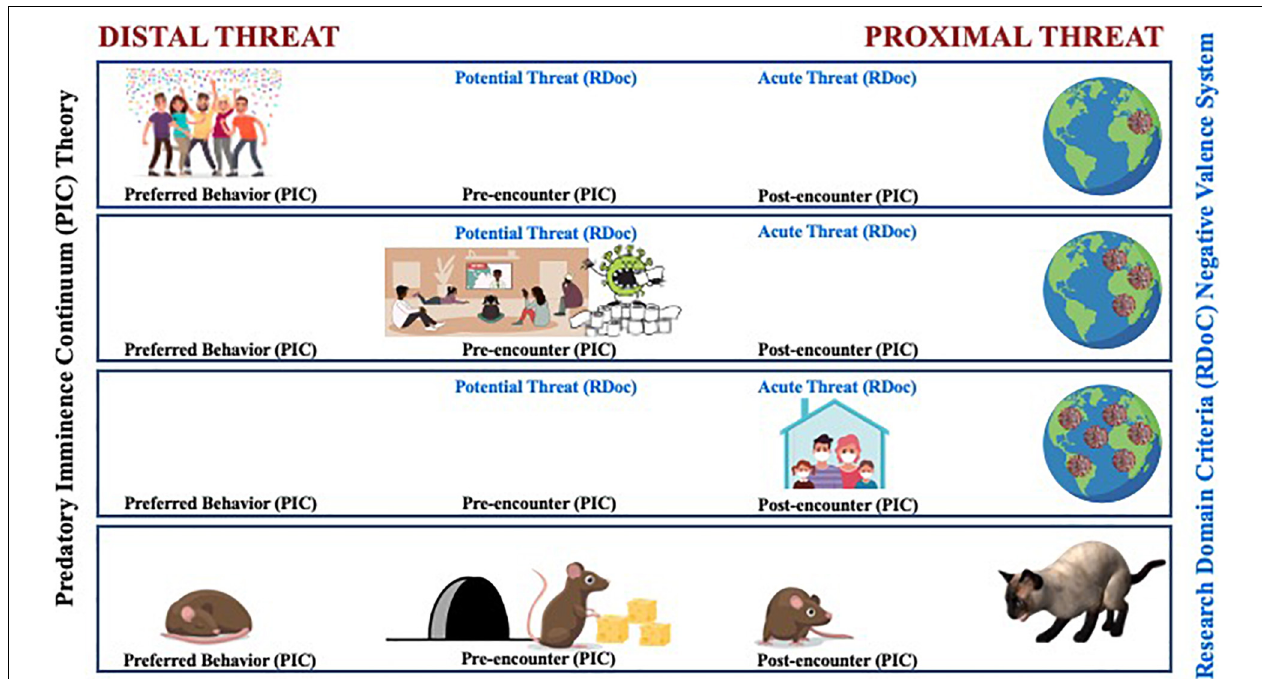
FIGURE 1 | A comparative illustration between the predatory imminence continuum (PIC) theory and the RDoC’s negative valence system’s representation of changes in defensive action patterns based upon the perceived psychological proximity to the COVID-19 virus. Early in the pandemic, the COVID-19 threat was considered distal and not something to be that concerned about. Social distancing was not part of the typical behavior; instead, people engaged in more preferred social interactions (top row). As coronavirus cases surged and regular reports of hospital admittance and death tolls rose, social interaction was replaced with stockpiling supplies in preparation for the potential and pre-encounter of the coronavirus (middle row). As the threat became more proximal, stay-at-home orders were put into effect as a way to help evade contact and increase survival (bottom row). Some aspects of the evolution of the imminence of COVID-19 from distal to proximal threat also follow patterned stages in the RDoC Negative Valence System that ranged from potential threat, where increased vigilance emerges under conditions of uncertain safety, to acute threat activated when a specific danger is